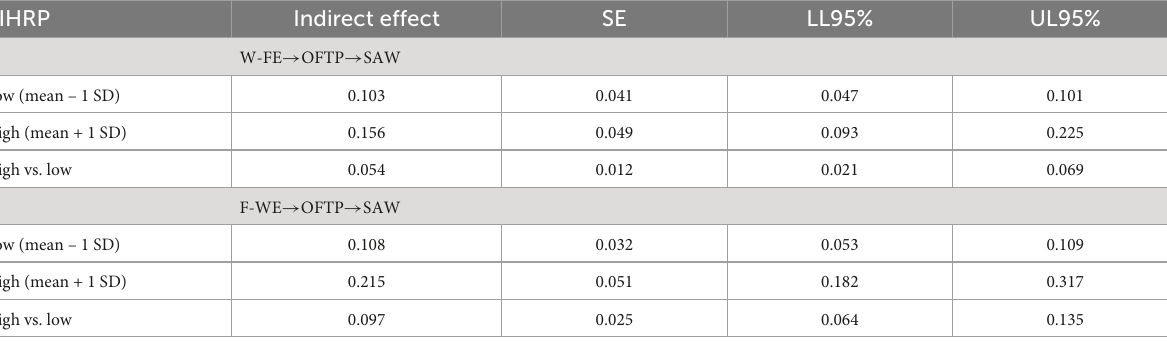
TABLE 7 Results of the moderated